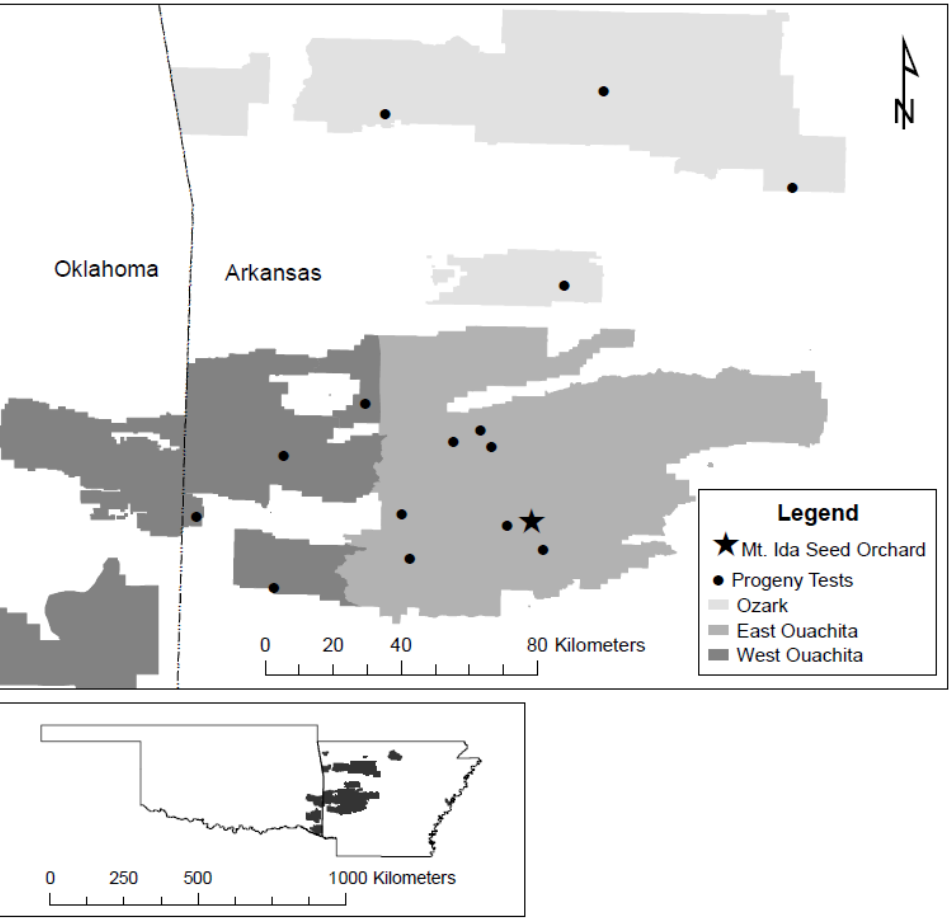
Figure 1. Fifteen shortleaf pine progeny test plantations (circles in black) sampled in the East Ouachita (grey background), West Ouachita (black background), and Ozark (light grey background) seed source regions. The star symbol denotes the location of the Mount Ida Seed Orchard in the Ouachita National Forest.